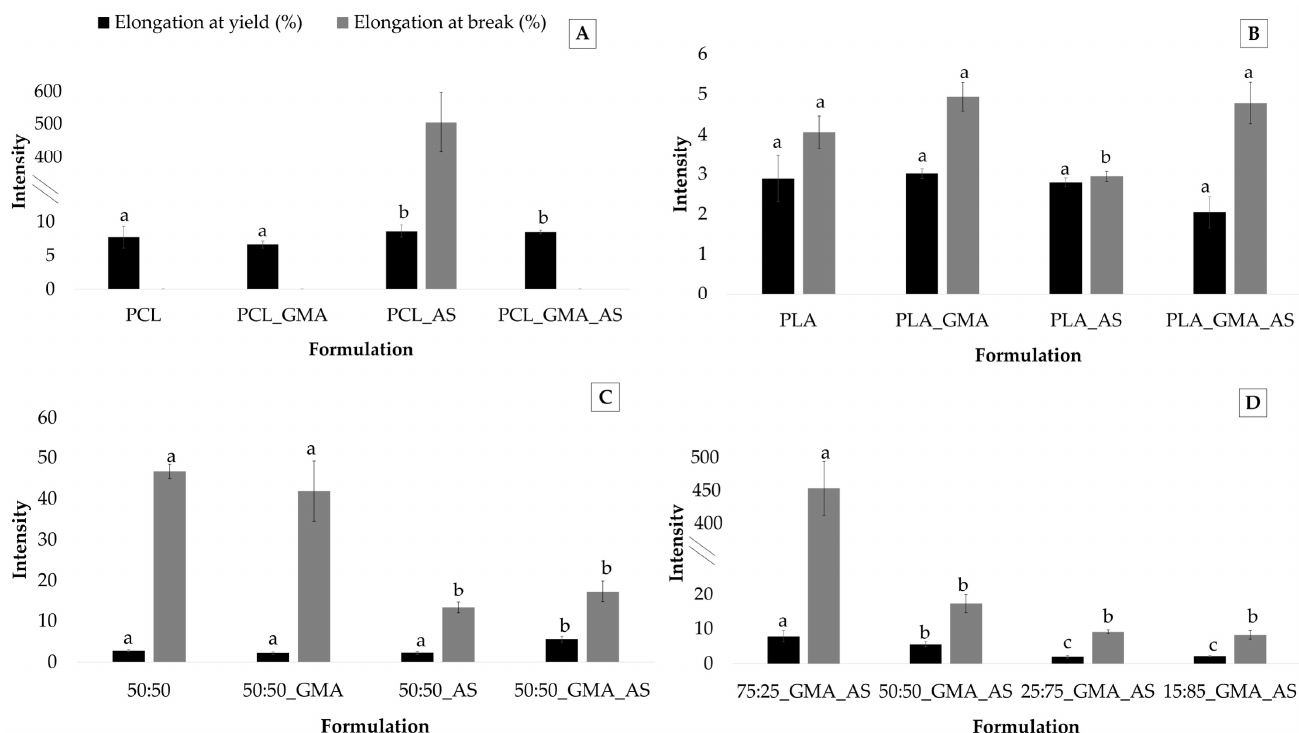
Figure 4. Elongation at yield (%) and elongation at break (%) ( n = 5) for PCL controls ( A ), PLA controls ( B ), PCL/PLA (50:50) controls ( C ), and PCL/PLA formulations ( D ). Mean ± SD. Different superscripts within the same parameter indicate statistically significant different values ( p < 0.05).